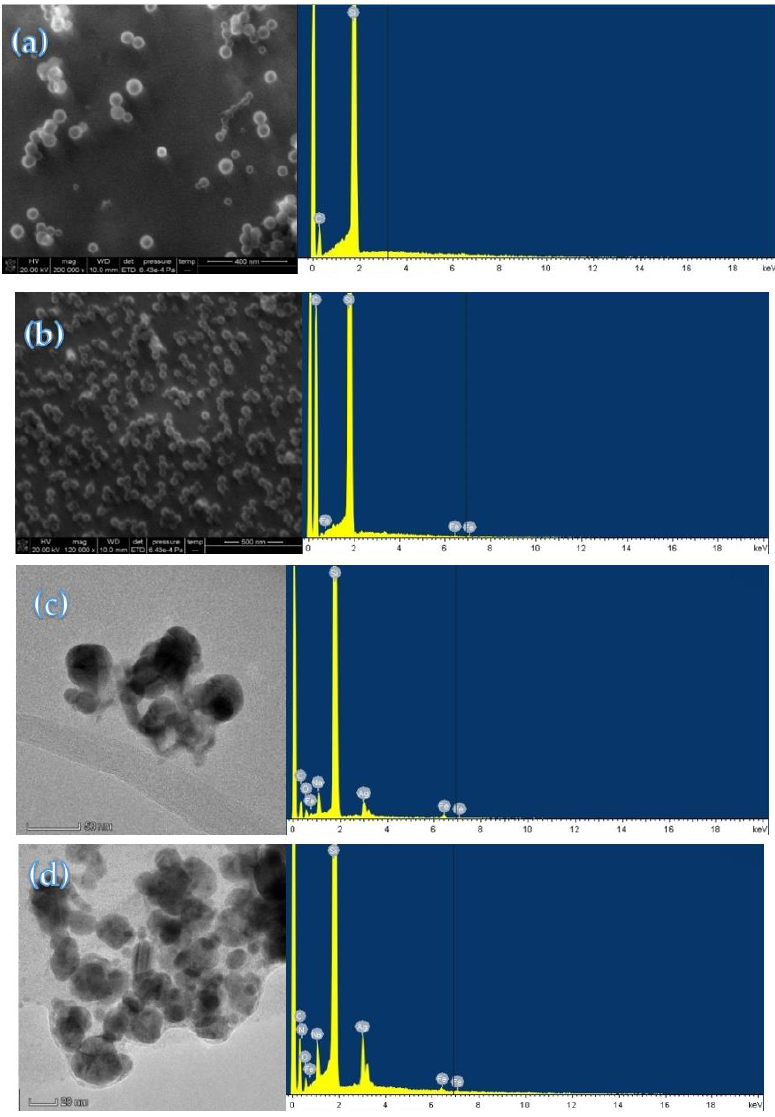
Figure 2. Electron microscope images and energy spectra of PN Fer and nanocatalytic analysis system. ( a ) 6.67 mg/L PN 3 ; ( b ) 6.67 mg/L PN Fer3 ; ( c ) 6 nM HM + 8 nM Apt + 6.67 mg/L PN Fer3 + 0.67 mM AgNO 3 + 53.2 mM SF; ( d ) 1.0 nM Pb 2+ + 6 nM HM + 8 nM Apt + 6.67 mg/L PN Fer3 + 0.67 mM AgNO 3 + 53.2 mM